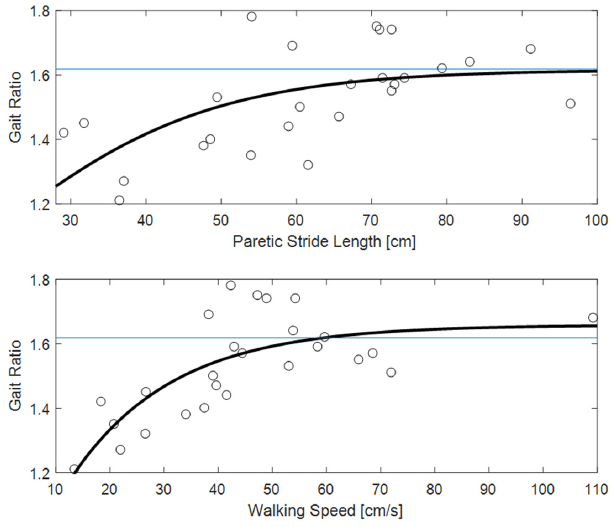
Figure 3. The gait ratio (stride duration/stance duration) reported with respect to paretic stride length ( top ) and walking speed ( bottom ). The horizontal blue line represents the theoretical value of the golden ratio (approximately 1.618); the wide black line is a bioexponential fit of the data.